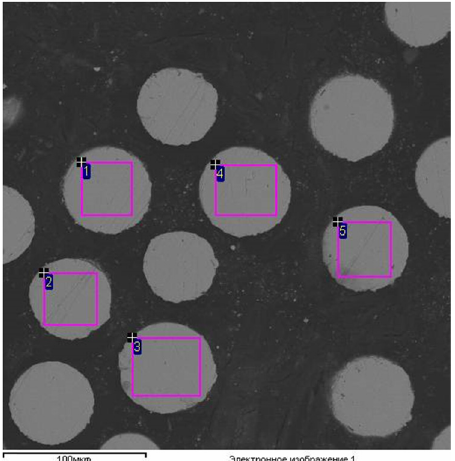
Figure 12: Example of determining the chemical composition of a powder after